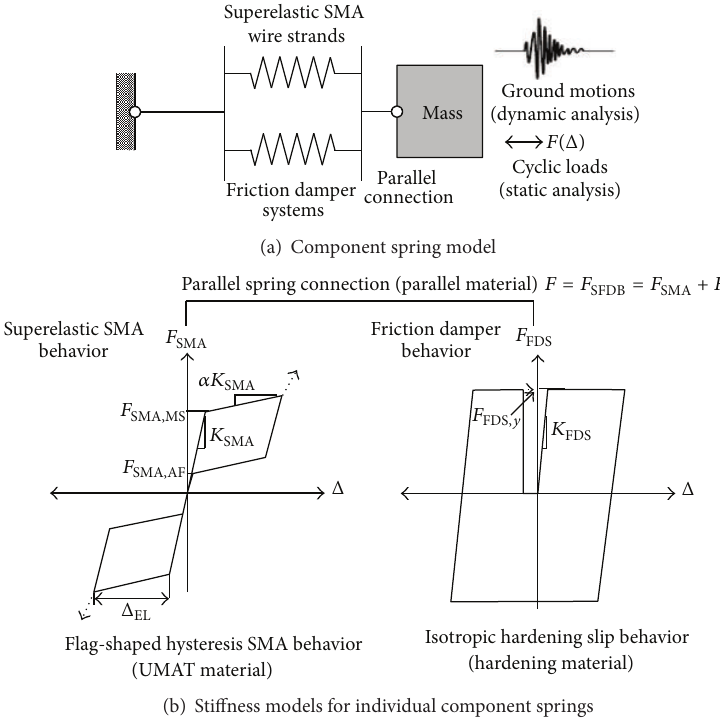
Figure 4: Modeling attributes for SFDB component spring